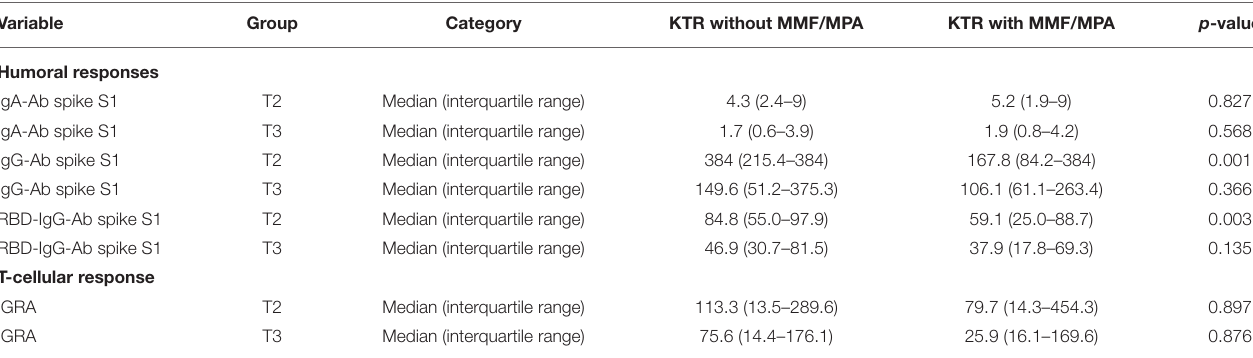
TABLE 3 | Antibody and interferon- γ release assay (IGRA) titers 2 (T2) and 6 months (T3) after vaccination in the seroconverted kidney transplant recipients (KTR) 112 cohort with and without mycophenolate mofetil or mycophenolic acid (MMF/MPA). Variable